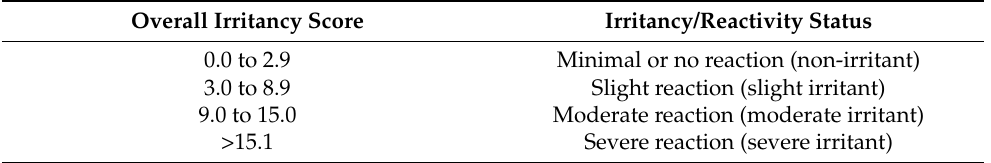
Table 3. Irritancy/Reactivity Grade. Adapted from DIN EN ISO